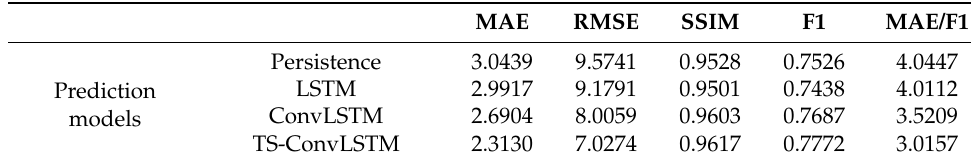
Table 3. Statistical comparisons according to model architectures.